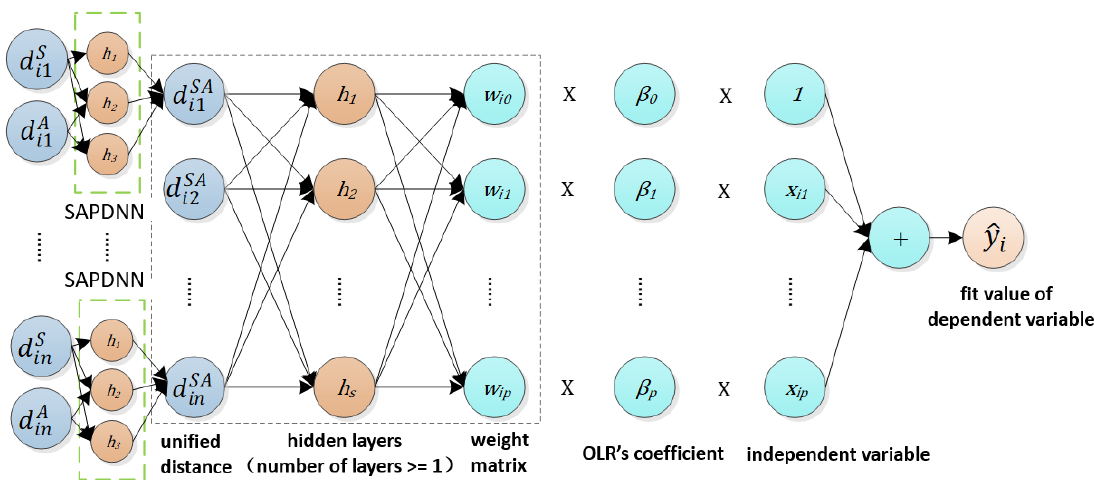
Figure 5. The structure of SANNWR.